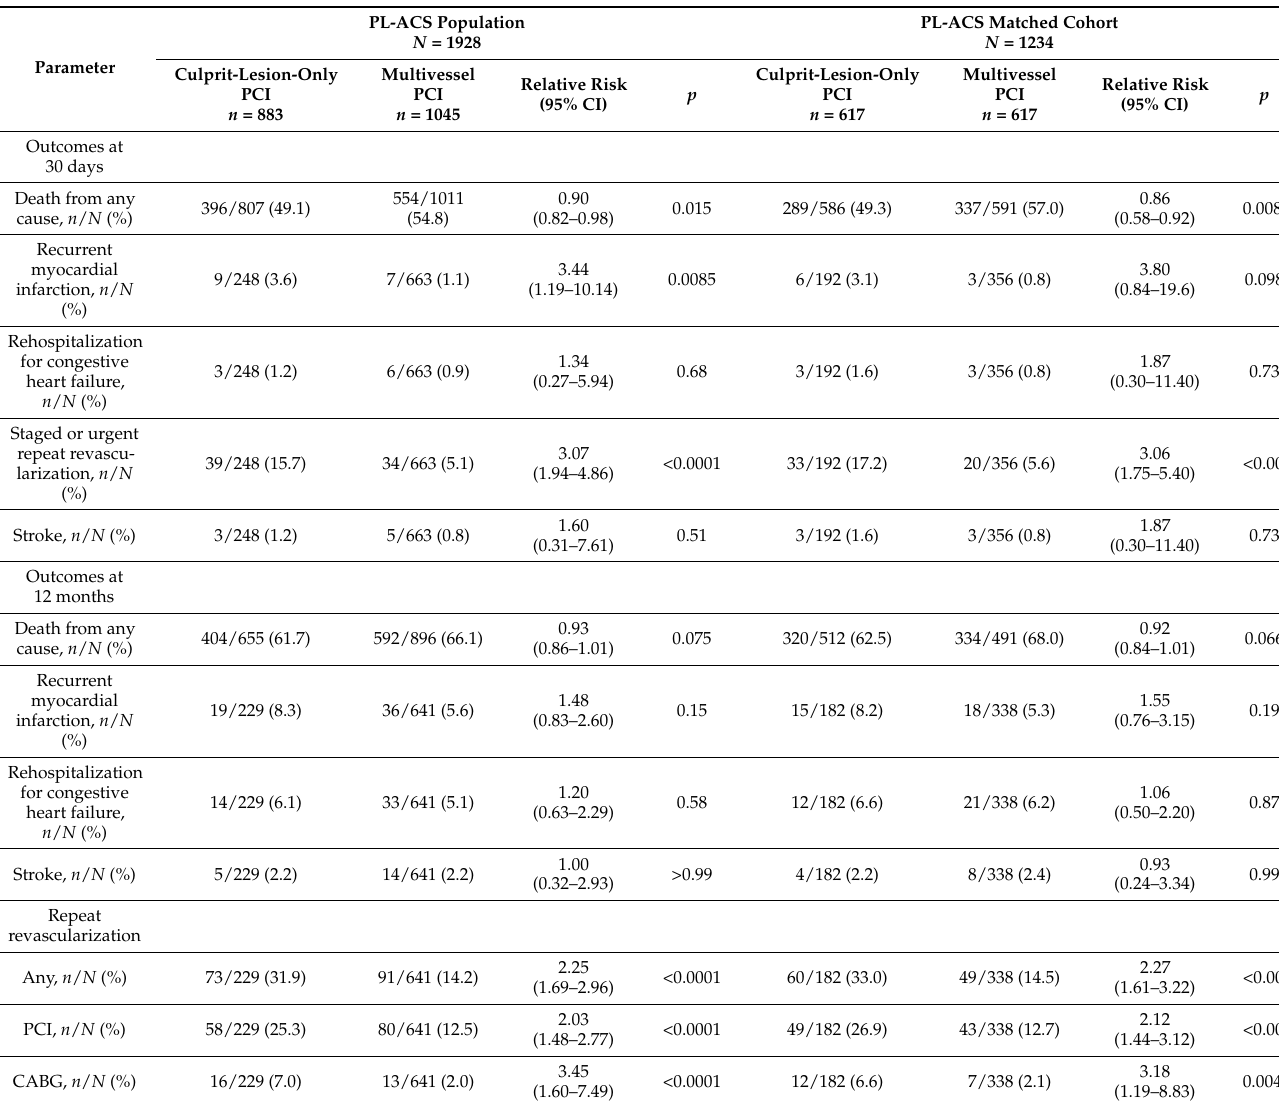
Table 3. Procedural characteristics of study groups of the PL-ACS registry and the CULPRIT-SHOCK trial.